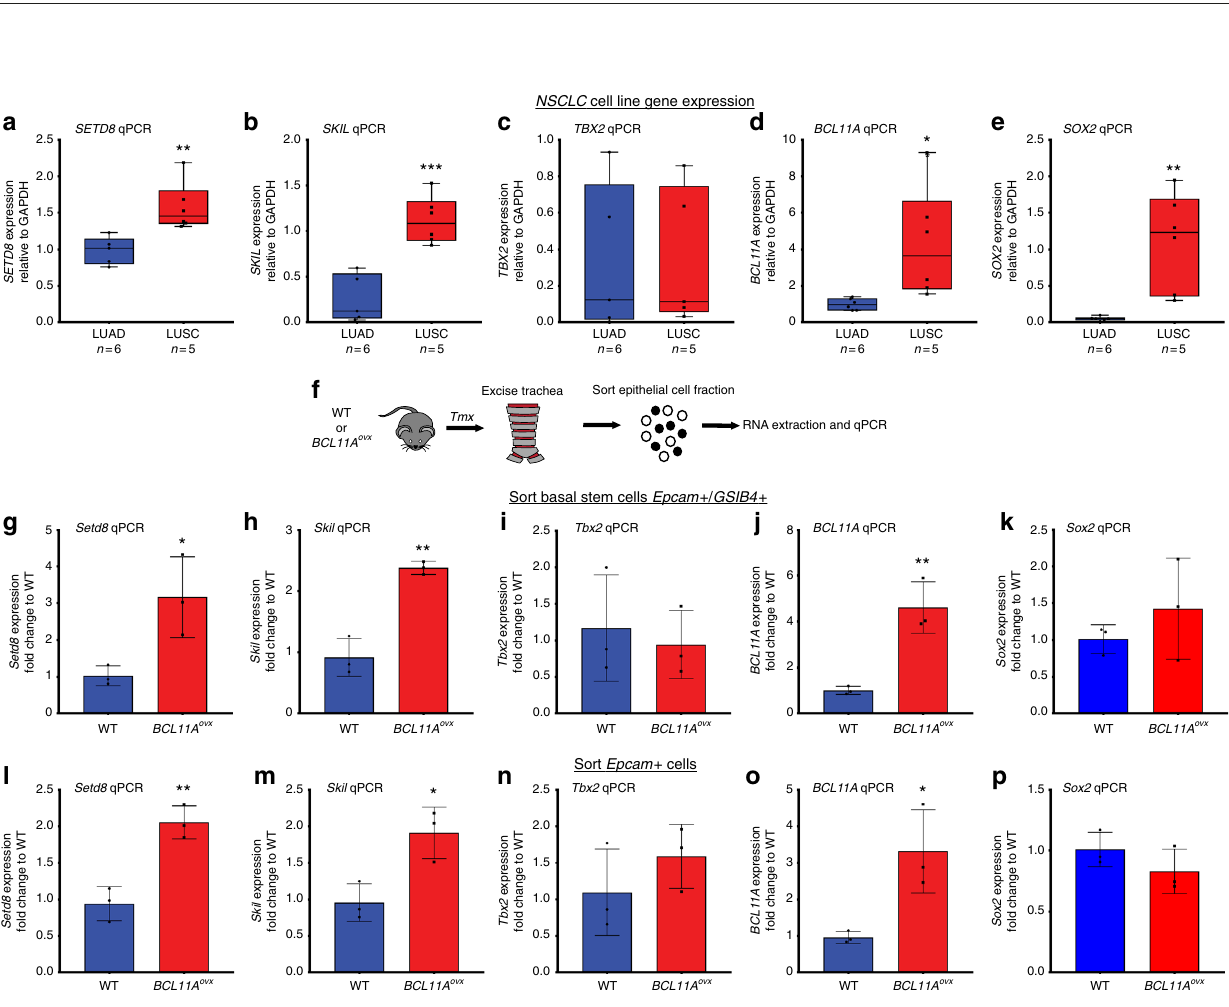
Fig. 4 BCL11A regulates both SETD8 and SKIL gene expression. SETD8 ( a ), SKIL ( b ), TBX2 ( c ), BCL11A ( d ), SOX2 ( e ) gene expression in NSCLC cell lines. f Sorting strategy for RNA extraction from WT or BCL11A OVX mice treated with tamoxifen. SETD8 ( g ), SKIL ( h ), TBX2 ( i ), BCL11A ( j ), SOX2 ( k ) gene expression in basal stem cells. SETD8 ( l ), SKIL ( m ), TBX2 ( n ), BCL11A ( o ), SOX2 ( p ) gene expression in epithelial Epcam + ve cells. The whiskers in all box plots represent minimum and maximum points. The box extends from 25th to 75th percentile and the line represents the median. Data presented as mean ± s.d. (LUSC n = 5 and LUAD n = 6; WT n = 3 and BCL11A OVX n = 3). Student ’ s t -test performed, * p < 0.05, ** p < 0.005, and *** p < Supplementary Fig. 11a, b, and c; LK2 Supplementary Fig. 11d, e, and f; H1792 Supplementary Fig. 11g, h, and i). We found that SETD8-KD had a pronounced effect on colony formation selectively in LUSC cells but not in LUAD cells (Fig. 5a, e, i). SKIL-KD, also reduced colony formation but affecting both LUSC and LUAD cells suggesting its importance in NSCLC (Fig. 5b, f, g). In contrast, TBX2-KD had no effect on either LUSC or LUAD cells suggesting that it does not play a key role in the pathology of these cells (Fig. 5c, g, k).